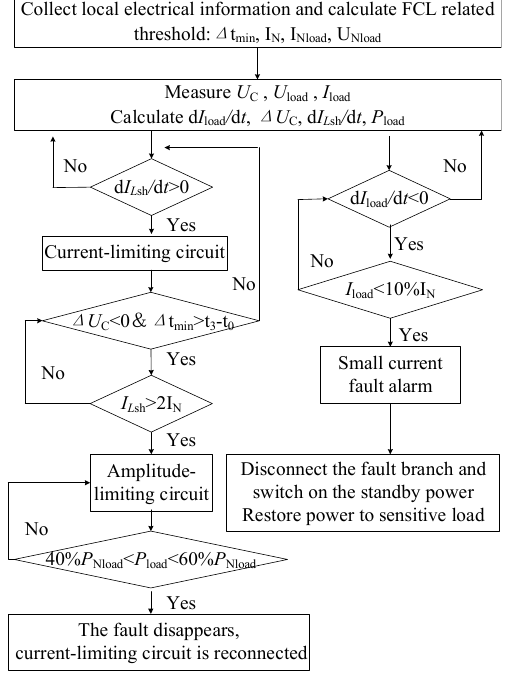
Figure 7. Fault ride-through strategy based on DC FCL.